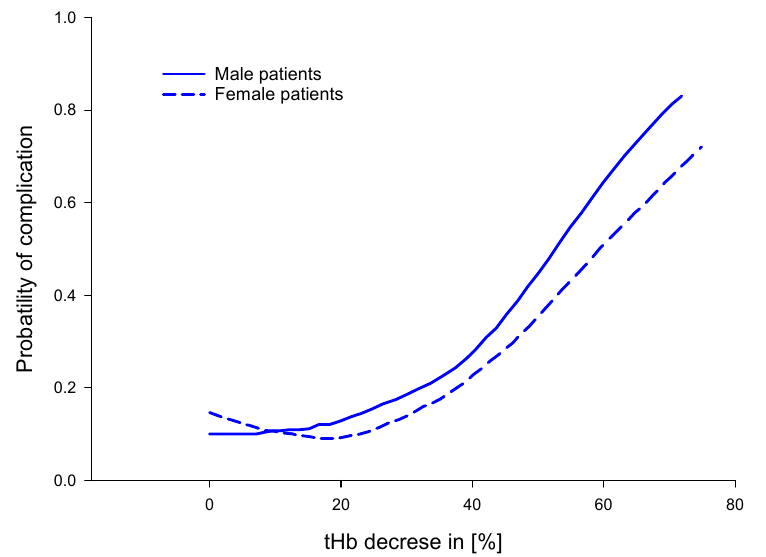
Figure 7. Relationship between decrease in tHb level and morbidity in patients who undergo major gastrointestinal surgery, stratified by sex. Adapted from [58].